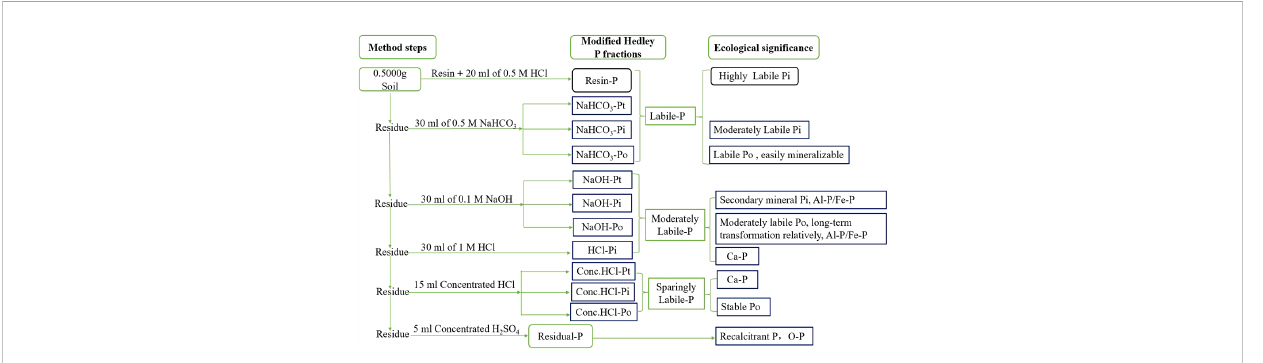
FIGURE 1 Modi fi ed P fractionation scheme, P i , P o , and P t represent the inorganic, organic and total P, respectively. NaHCO 3 -P t =NaHCO 3 -P i +NaHCO 3 -P o ; NaOH-P t =NaOH-P i + NaOH-P o